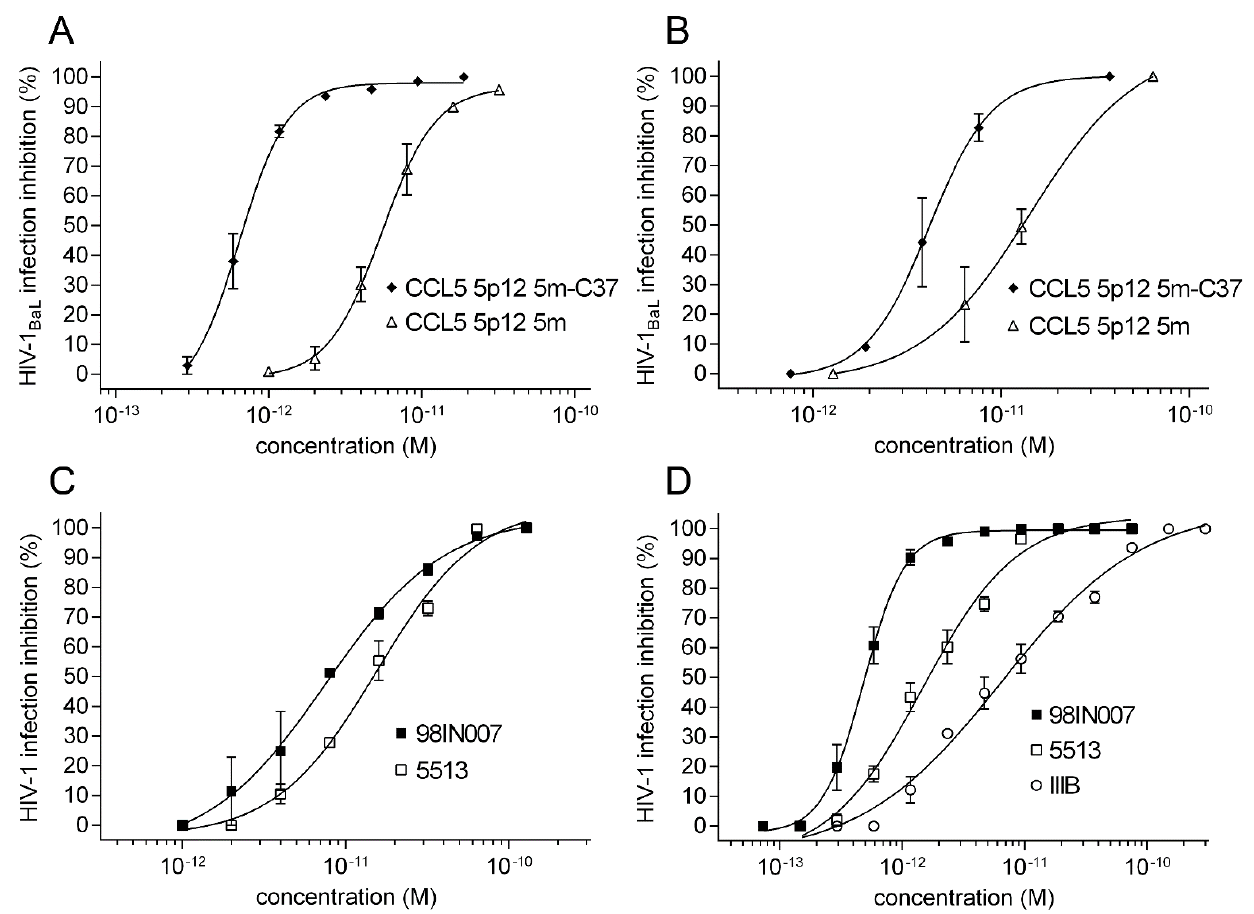
Figure 3. Anti-HIV-1 activity of CCL5 5p12 5m-C37. ( A ) Inhibition of R5 tropic laboratory-adapted clade B HIV-1 BaL by CCL5 5p12 5m-C37 tested by acute infection in PM1 cells and measured by a p24-based assay after 4 days of infection. ( B ) HIV-1 BaL inhibition of CCL5 5p12 5m-C37 tested by